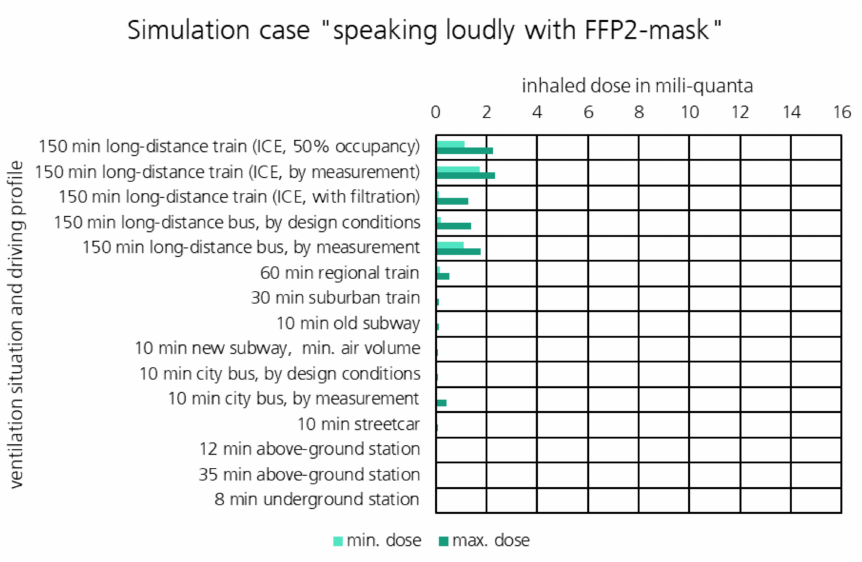
Figure 17. Comparison of typical means of transport considered for the case “Speaking loudly with FFP2”: min. dose, minimum dose absorbed farther away from the emitter; max. dose, maximum exposure that is absorbed close to the